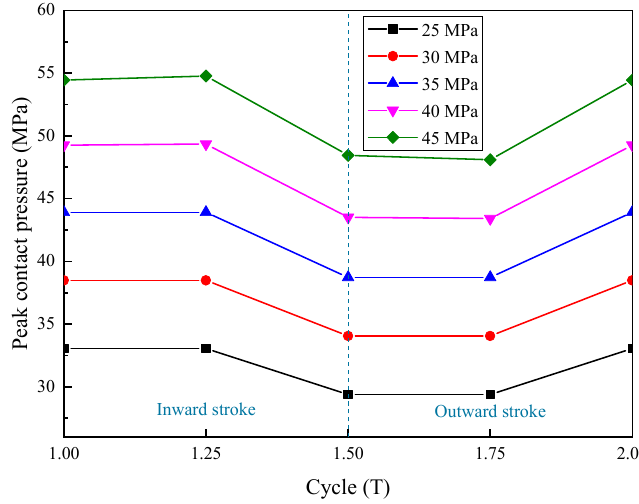
Figure 12. Relationship between peak contact pressure and P h during 1–2 T. Figure 13 exhibits the relationship between the peak Mises stress of X-ring and P h